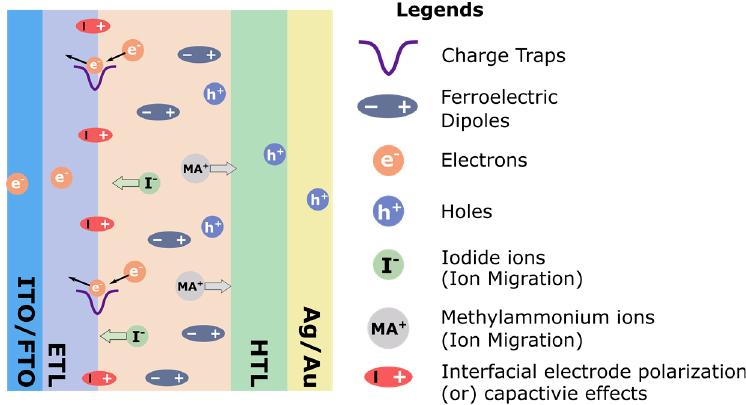
Figure 5. Schematic of the proposed contributions to hysteresis. ITO, FTO, ETL and HTL stand for indium-doped tin oxide, fluorine-doped tin oxide, electron transport layer, and hole transport layer, respectively. Reproduced from ref. [76], with permission from Elsevier, 2016.